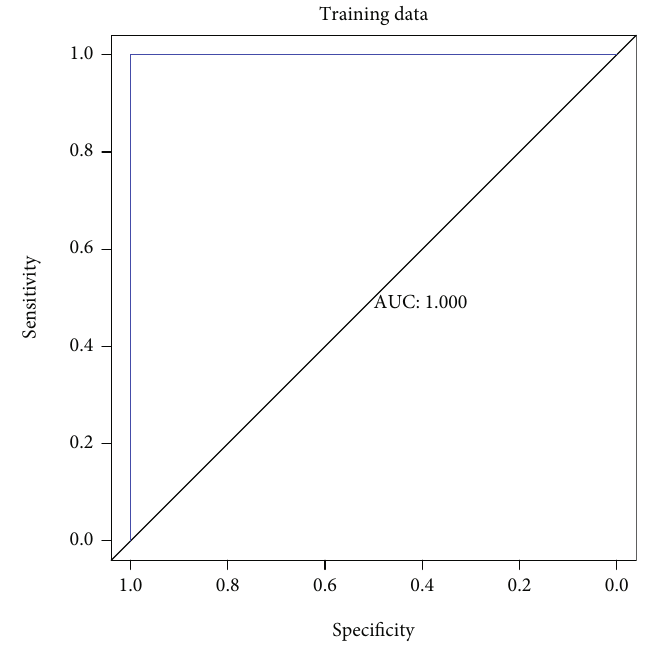
Figure 5: Receiver-operating characteristic (ROC) curve of the training